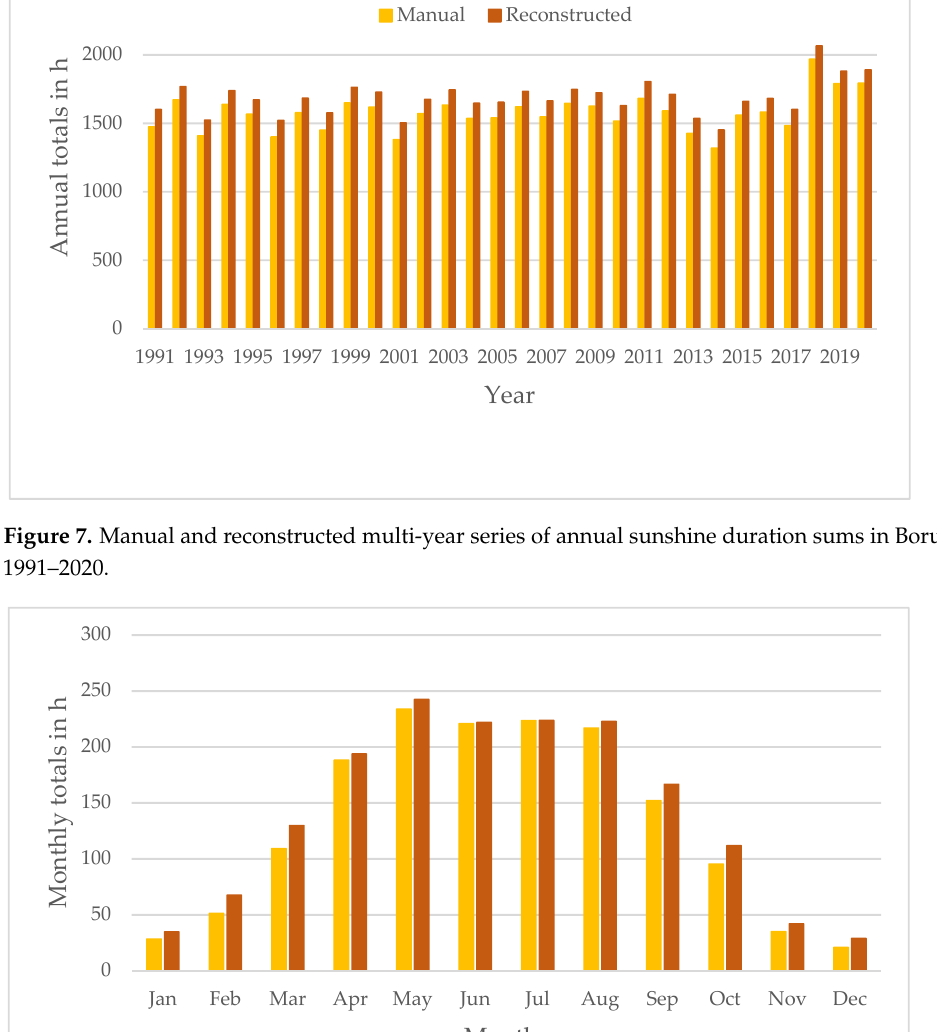
Figure 7. Manual and reconstructed multi-year series of annual sunshine duration sums in Bo- rucino, 1991–2020.